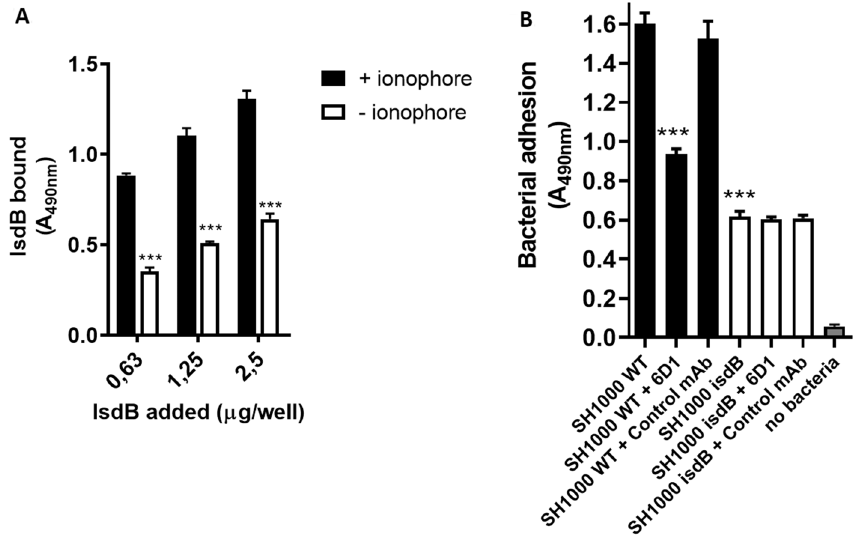
Figure 7. IsdB-mediated adhesion to HUVEC cell monolayers. (A) Confluent umbilical vein endothelial cell (HUVEC) monolayers were incubated with the calcium ionophore A23187 and fixed with paraformaldehyde. The monolayers were incubated with the indicated amounts of IsdB NEAT1-NEAT2 and binding of the ligand to the cells was detected by addition to the wells of a rabbit polyclonal IsdB antibody followed by an treated as reported in A were incubated with S. aureus SH1000 WT and isdB mutant bacteria. Adherence to the monolayers was detected by the addition of HRP-conjugated rabbit anti-mouse IgG to the wells.